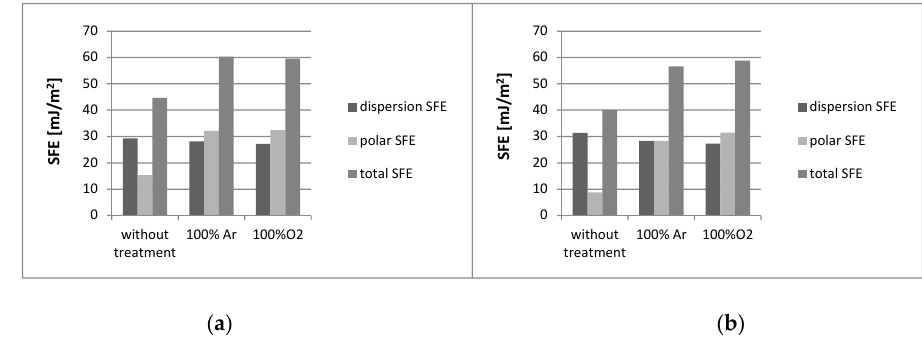
Figure 2. Changes in surface free energy for ( a ) NTSS film; ( b ) BCP film.